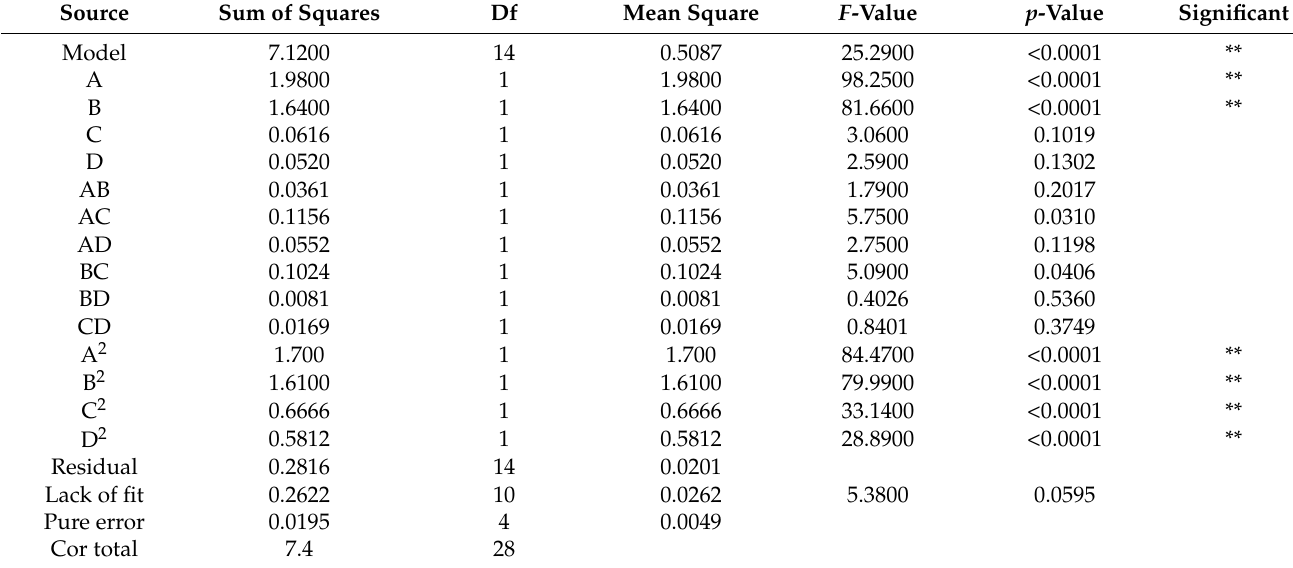
Table 3. Analysis of variance of the quadratic model of the response surface.